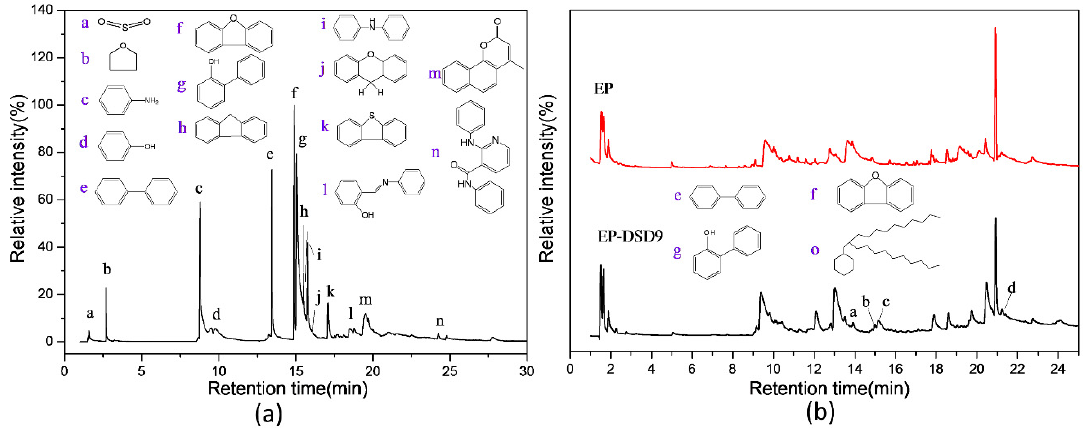
Figure 9. Pyrograms of DSD ( a ), and neat EP and EP–DSD ( b ) thermosets.